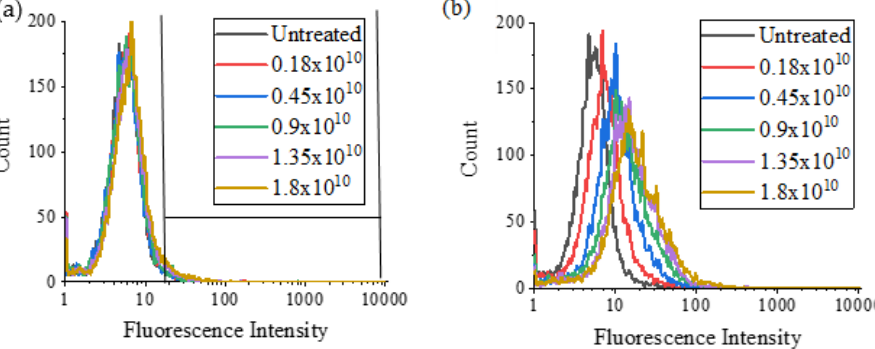
Figure 8. Live cell flow cytometry of MSCs in PBS labelled with various numbers of ( a ) NV-40 and ( b ) NV-90 NDs for 24 h. Fluorescence intensity was measured using the FL3 filter (670 LP), where 10,000 events were counted, and the fluorescence gating used for all experiments was the same as in ( a ).